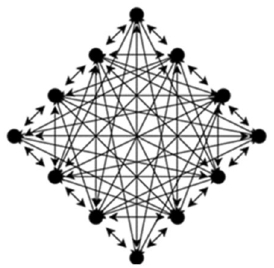
Figure 1. Single mesh network